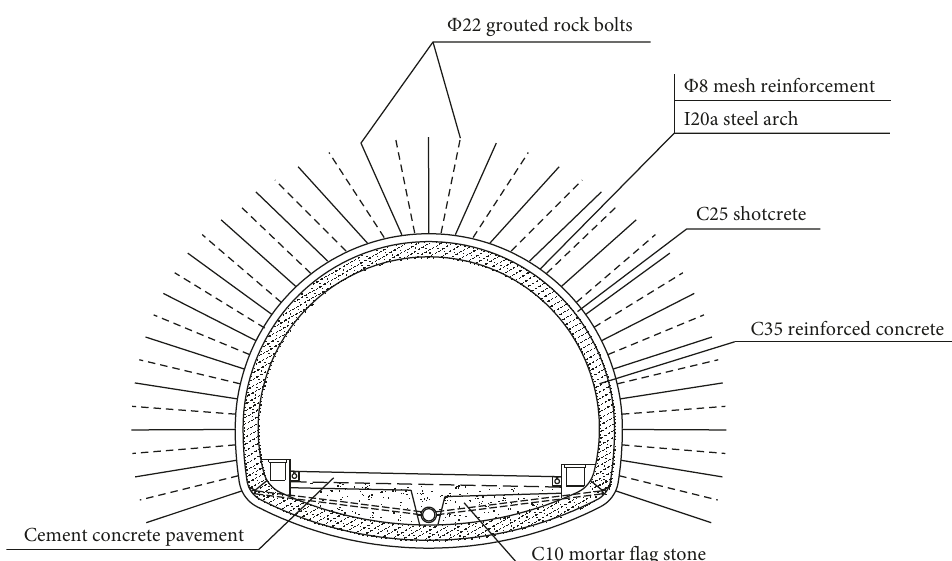
Figure 9: Schematic diagram of the tunnel support